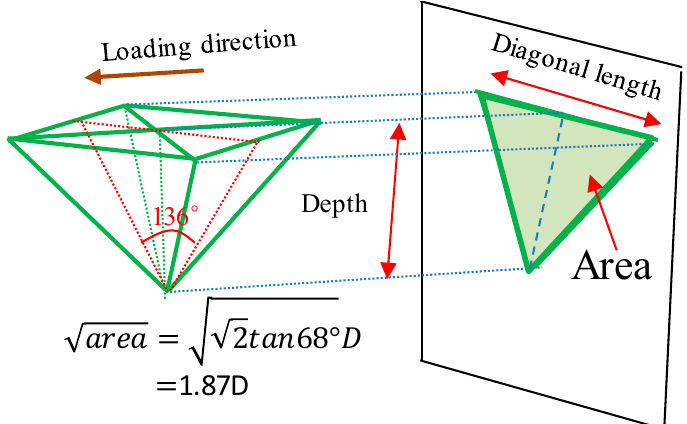
Figure 10. A schematic view of the indent area.